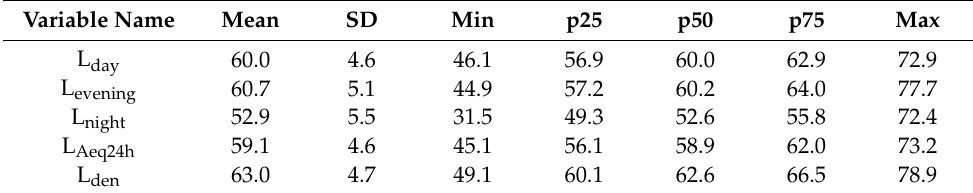
Table 2. Summary statistics (mean, standard deviation (SD), minimum (min), 25th percentile (p25), 50th percentile (p50), 75th percentile (p75), maximum (max)) of the measured noise levels for five different metrics (L day , L evening , L night , L Aeq24h , and L den ), in A-weighted decibels ([dB(A)]).